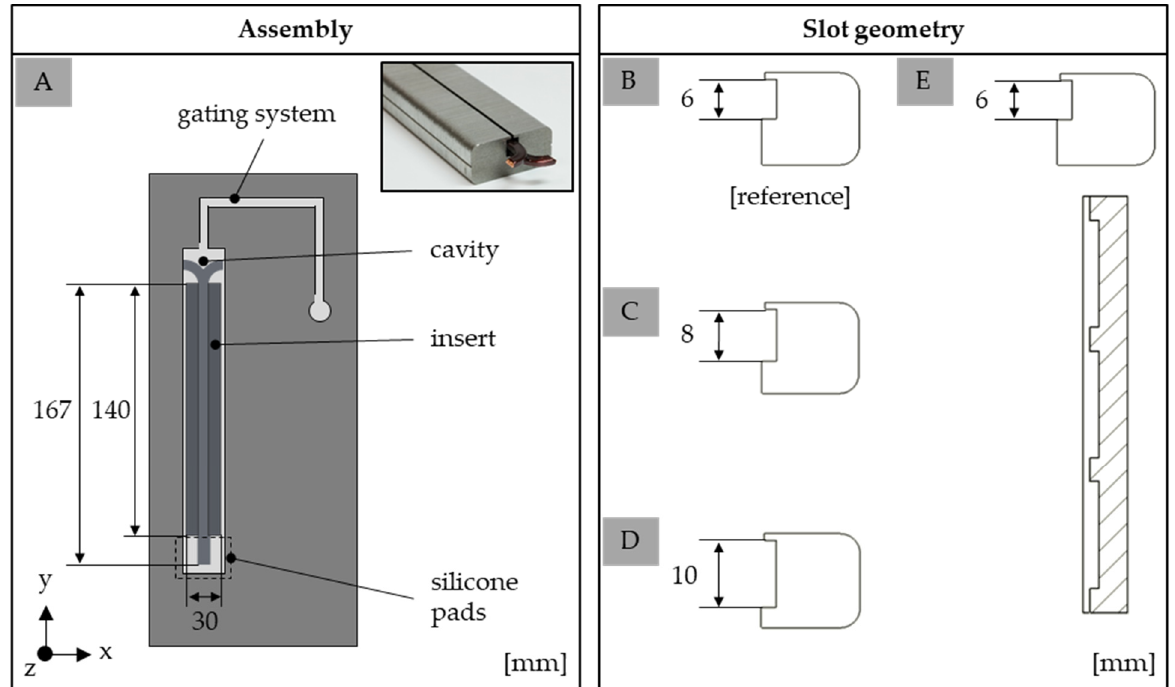
Figure 1. Schematic assembly of the tool to fabricate the single slot sample ( A ) and detailed dimension of the different slot geometries ( B – E ).